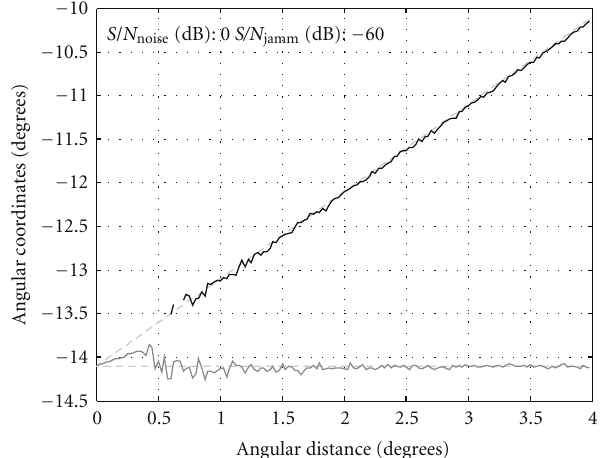
Figure 6: Histogram of polar coordinates evaluated by using the TLS ESPRIT method for the plane velocity v = 1000m/s, T p = 4ms, and S/N noise = 30dB.